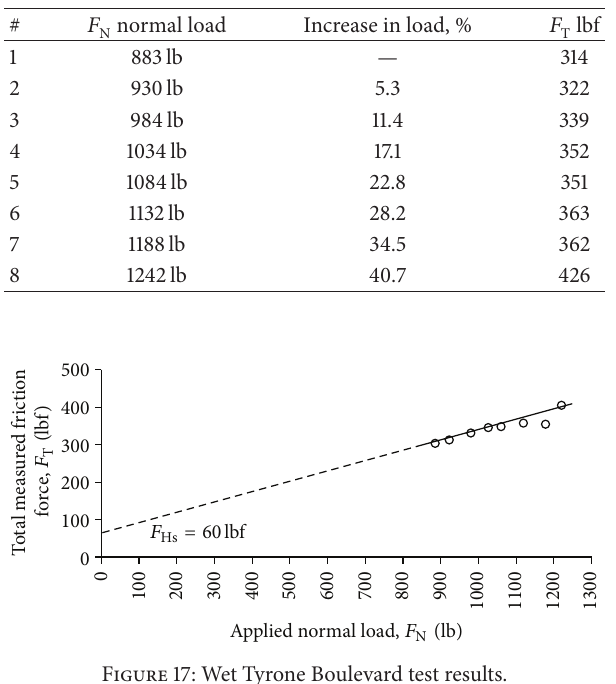
Table 5: Individual weights selected for use in controlling the ) applied to test tire during lockups and measured dynamic load ( 𝐹 N 𝐹 values wet concrete pavement testing. T